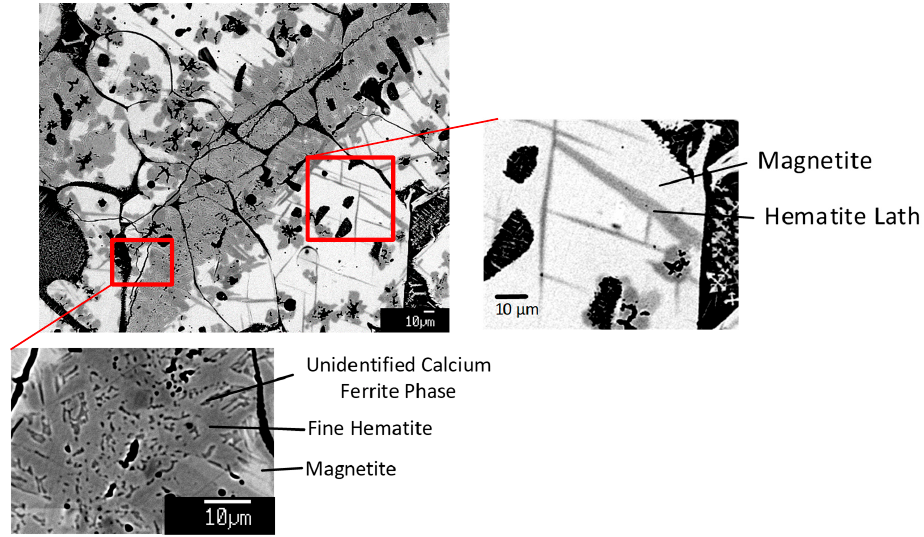
Figure 22. Example of dense hematite and associated microstructures observed from magnetite at 1400 ◦ C and reheated in air at 1200 ◦ C for 4 min (94.33 wt % Fe 2 O 3 and a CaO / SiO 2 ratio of 5.32 wt / wt) formed at 1400 °C and reheated in air at 1200 °C for 4 min (94.33 wt % Fe 2 O 3 and a CaO/SiO 2 ratio of (BSE 5.32 wt/wt) (BSE Micrograph).